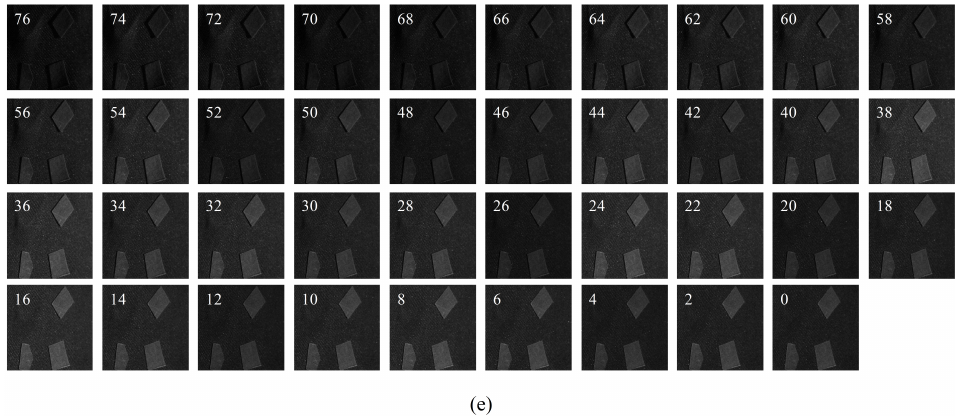
Figure 7. Diagram of all the images to be segmented: ( a ) Group 1; ( b ) Group 2; ( c ) Group 3; ( d ) Group 4; ( e ) Group 5. Note that the incident angles of light are marked on the images.